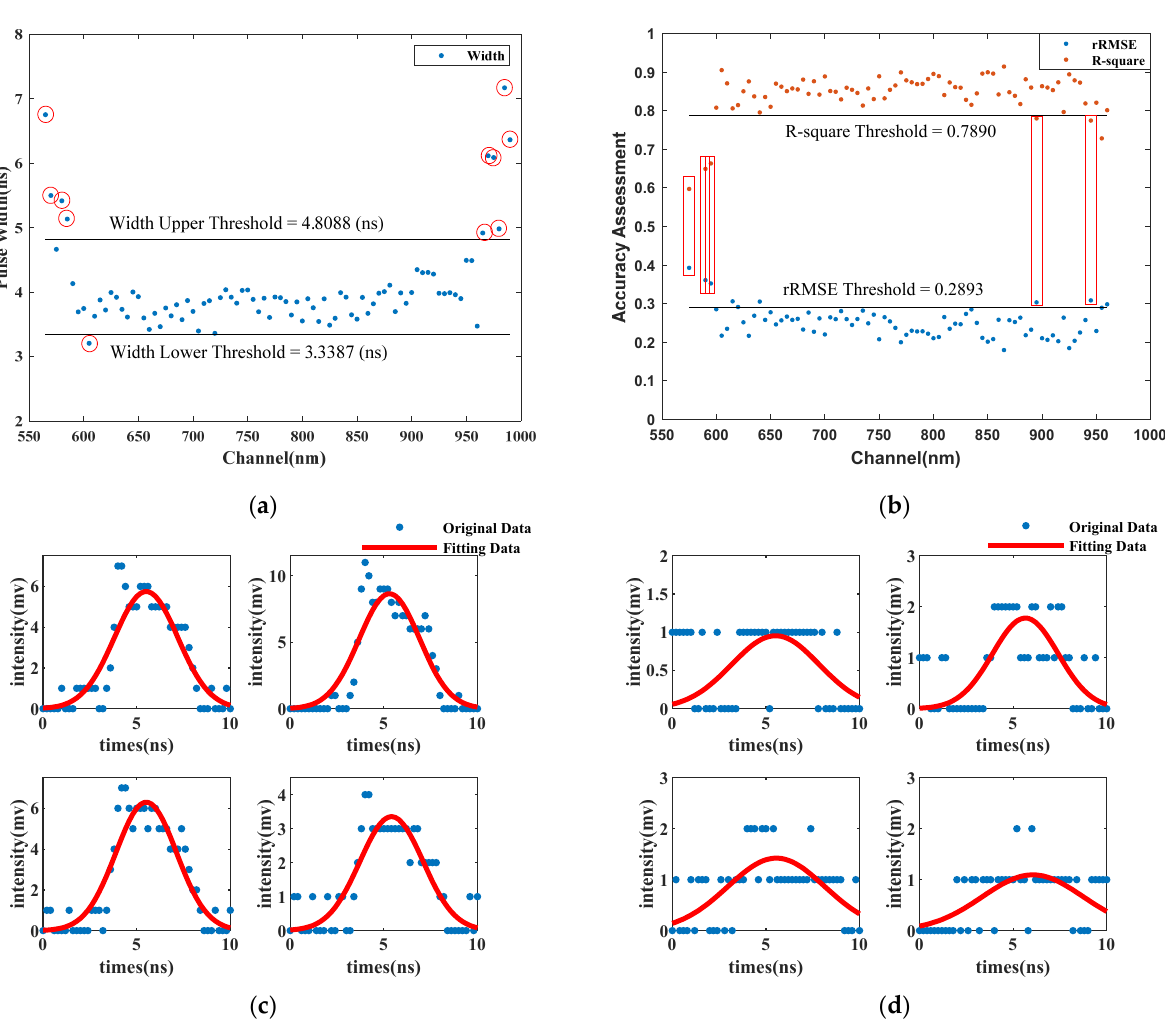
Figure 5. Process of selecting channels and fitting results of part of channel transmitter pulses of laser point, including qualified and unqualified channels. ( a ) Step 1: Select channels that exceed the pulse width threshold; ( b ) Step 2: Select channels that exceed the accuracy threshold. ( c ) Some bad fittings of transmitter pulse; ( d ) Some good fittings of transmitter pulse. Table 3. Starting position of each channel and maximum